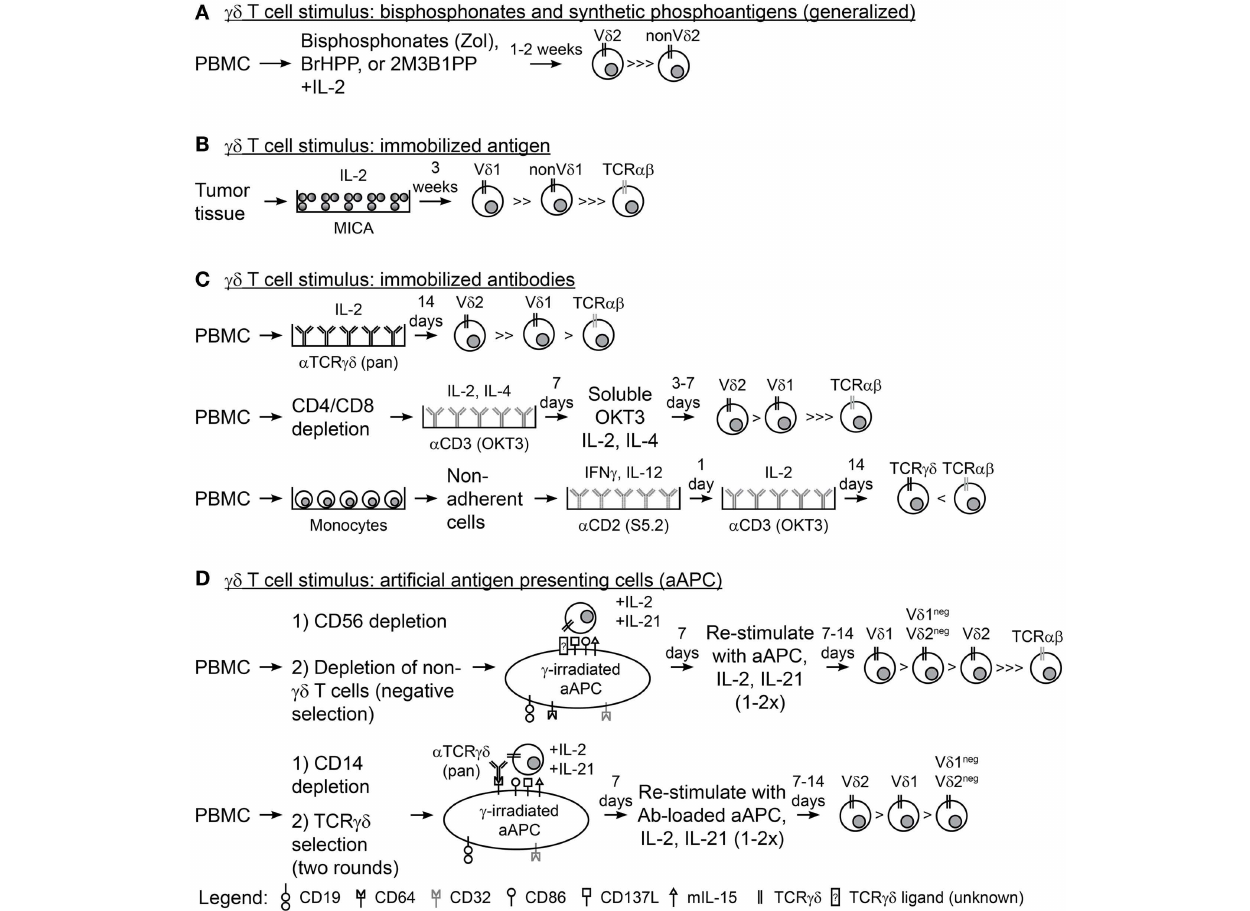
FIGURE 1 | Methodologies for expanding γδ T cells ex vivo . (A) A generalized schematic for the use of aminobisphosphonates (Zol, zoledronic acid) or synthetic phosphoantigens (BrHPP, bromohydrin pyrophosphate; 2M3B1PP, 2-methyl-3-butenyl-1-pyrophosphate) and interleukin-2 (IL-2) to expand γδ T cells from peripheral blood mononuclear cells (PBMC). (B) Plate-bound MHC class-I chain-related (MICA) and IL-2 were used to expand γδ T cells from colon and ovarian tumor tissues. (C) Immobilized antibodies (Ab) were used to expand γδ T cells from PBMC in three scenarios: (top) PBMC directly stimulated with anti-pan-TCR γδ Ab and IL-2, (middle) PBMC depleted of CD4 and CD8T cells followed by two rounds of stimulus with anti-CD3 Ab (OKT3), IL-2,